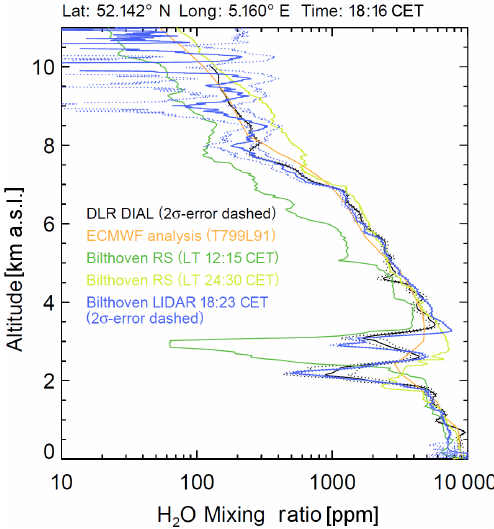
Figure 4. Sonde ozone and relative-humidity profiles above Pay- erne on 17 October 2008; the times are launch times.